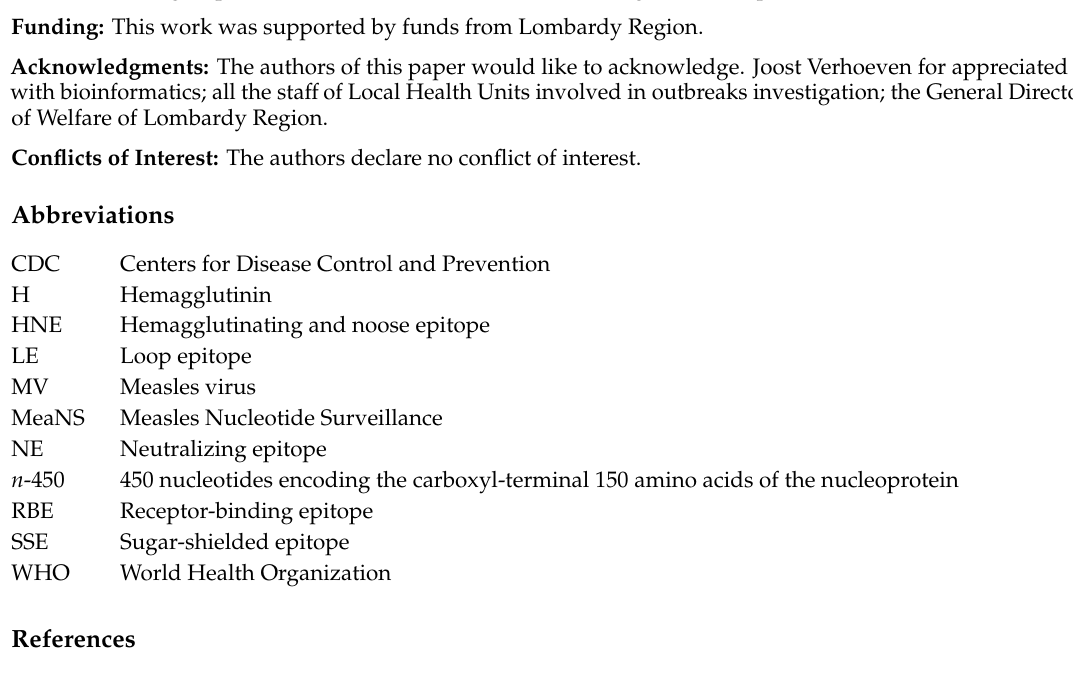
Figure S4. Phylogenetic analysis of MV genotype D8 hemagglutinin gene. Figure S5. Phylogenetic analysis of Lombardy MV genotype D8 hemagglutinin partial